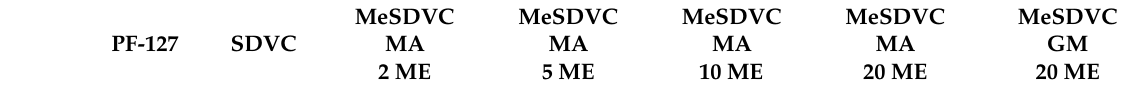
Table 1. Printing parameters used on the BioAssemblyBot for each hydrogel